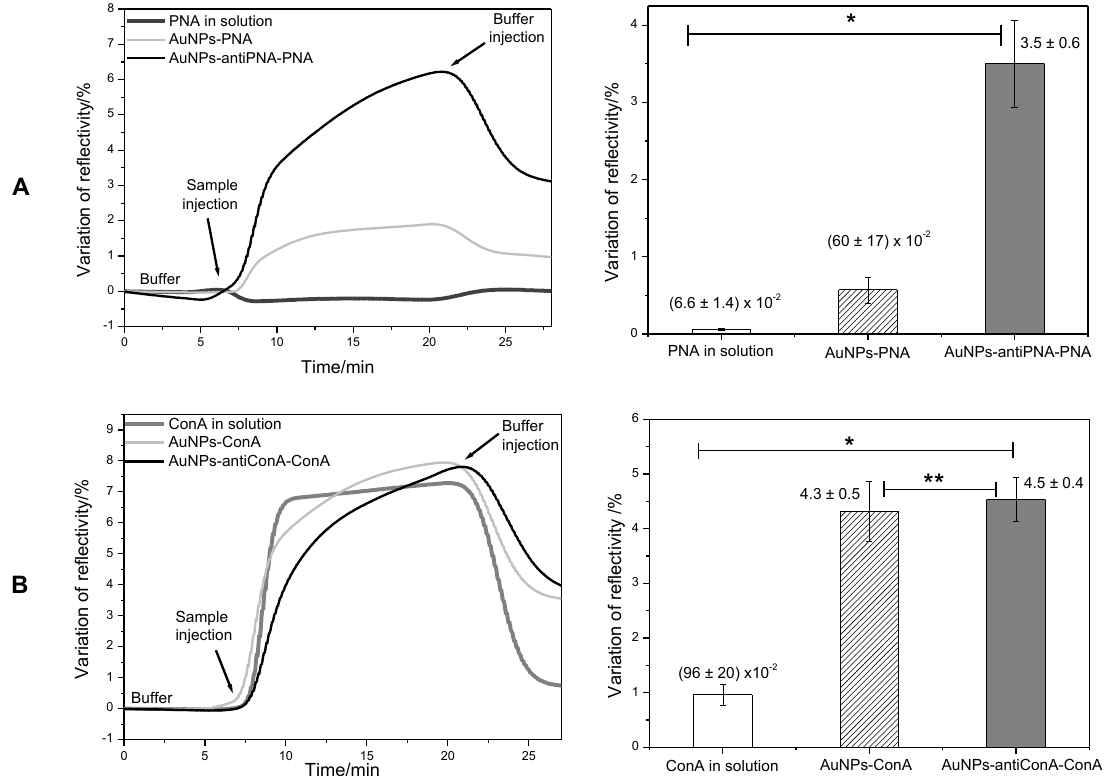
Figure 4. Kinetics curves and mean value of the variation of reflectivity on spots of antibody anti-PNA ( A ) and on spots of antibody anti-ConA ( B ) after the injection of proteins in solution (dark gray), proteins covalently linked to gold NPs (light gray) and proteins captured by gold NPs functionalized with antibody anti-PNA or anti-ConA (black) at the concentration of 94 nM. * Values significantly different (ANOVA; p < 0.05). ** Values not significantly different (ANOVA; p <